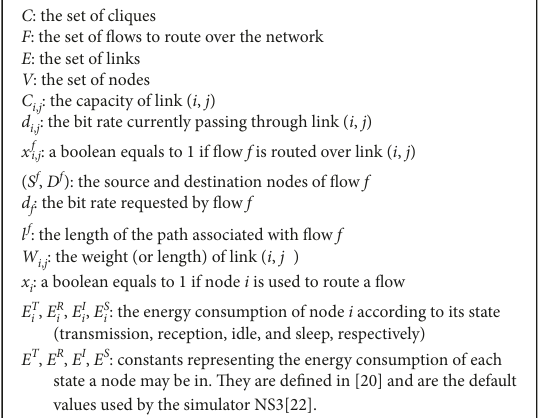
Figure 1: Notations used throughout this paper.